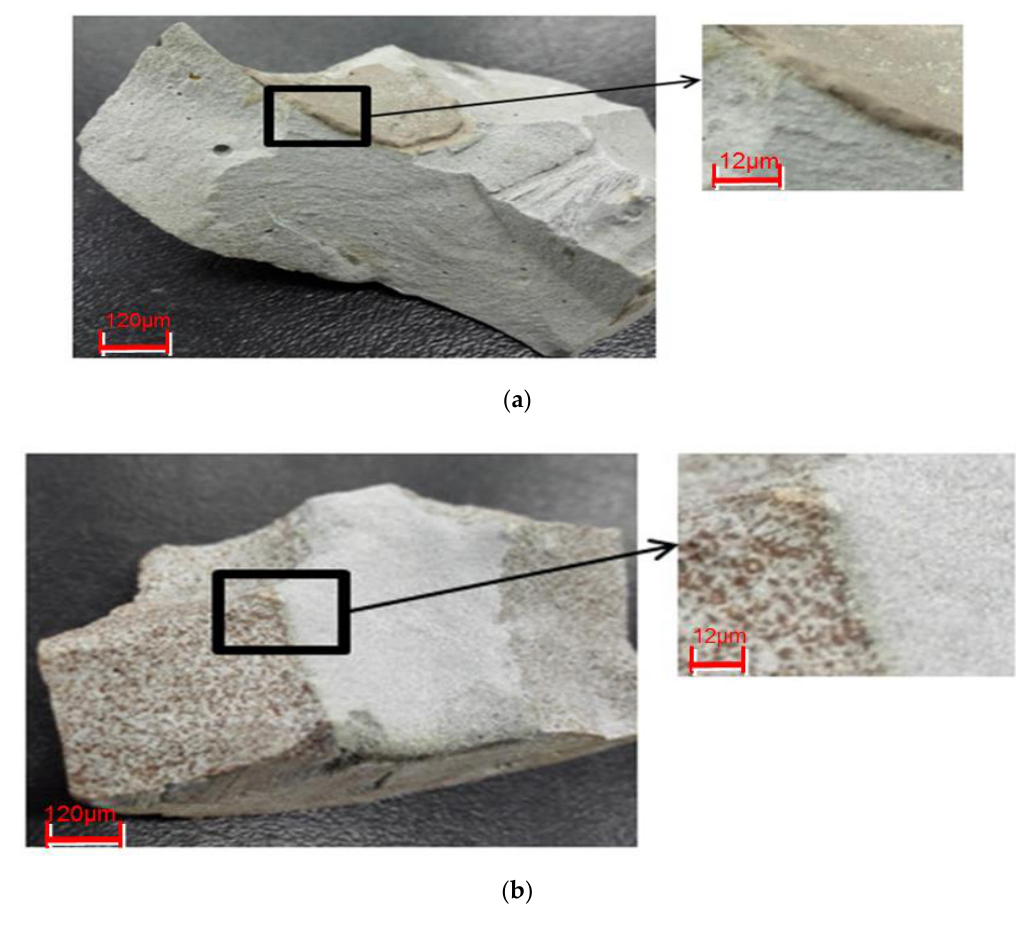
Figure 15. Microscopic morphology of interface between core and cement stone under different conditions. ( a ) is schematic diagram of observation position of adhering drilling fluid core and cement stone sample, ( b ) is schematic diagram of observation position of blank core and cement stone sample